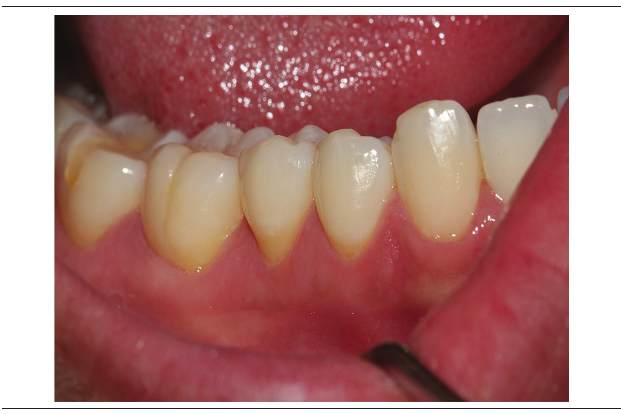
Figura 4 − Aspecto clínico 22 meses após a excisão da lesão sem sinais de